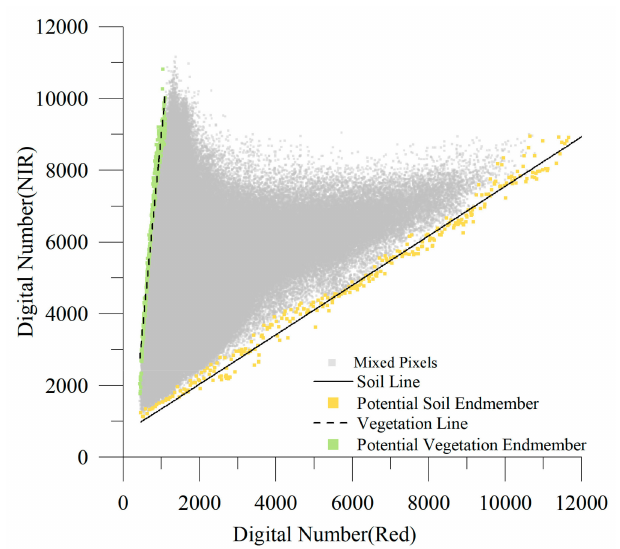
Figure 4. An example of the soil line and vegetation line. The origin and green points are the pixels used to fit the soil and vegetation lines, and these points, together with all the pixels below the soil line and above the vegetation line, are used to calculate the soil and vegetation reflectance